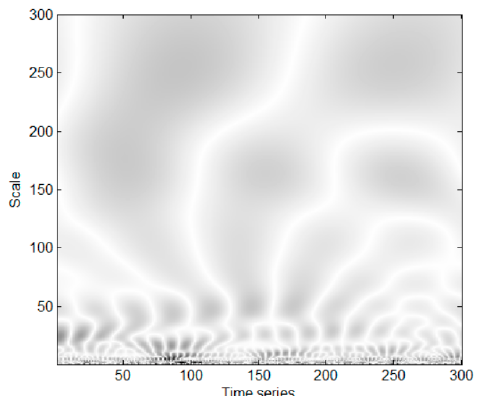
Figure 2. Continuous Wavelet Transform Scalogram (CWTS) of a ball fault bearing signal. The darker pixels correspond to larger wavelet coefficients.